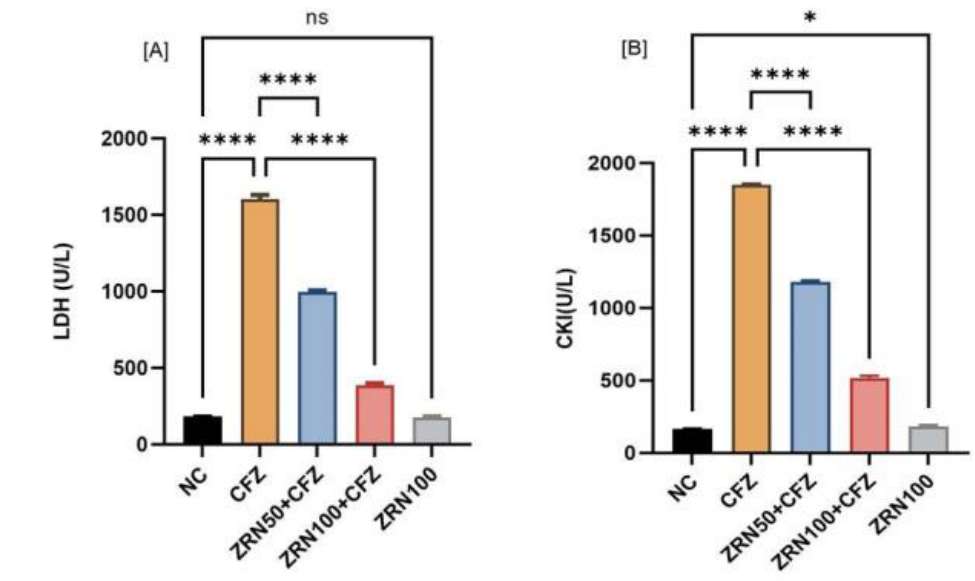
Figure 1. ( A , B ) The effects of zingerone on lactate dehydrogenase (LDH) and creatinine kinase (CKI) after carfilzomib administration in rats. Data are represented as means ± sd ( n = 8). The level of LDH and CKI increased significantly (**** p < 0.0001) in CFZ, as compared to NC. While the treatment with zingerone reduced these markers significantly (**** p < 0.0001), as compared to CFZ administrations. No changes were found in zingerone alone treatment, except in CKI. In CKI, zingerone alone treatment was significantly high, as compared to normal controls. Abbreviations: NC: Normal control, CFZ: Carfilzomib, ZRN: Zingerone.